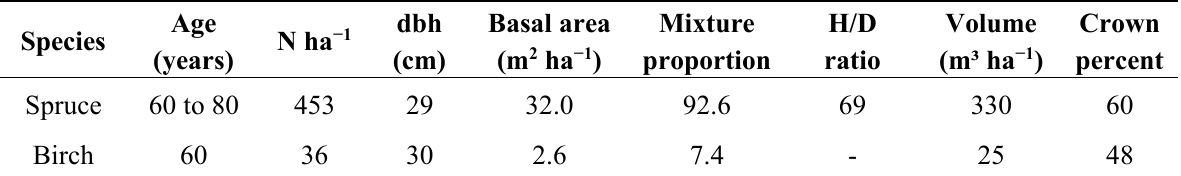
Table 1. Description of the spruce-birch stand studied in the Ore Mountains, Germany.